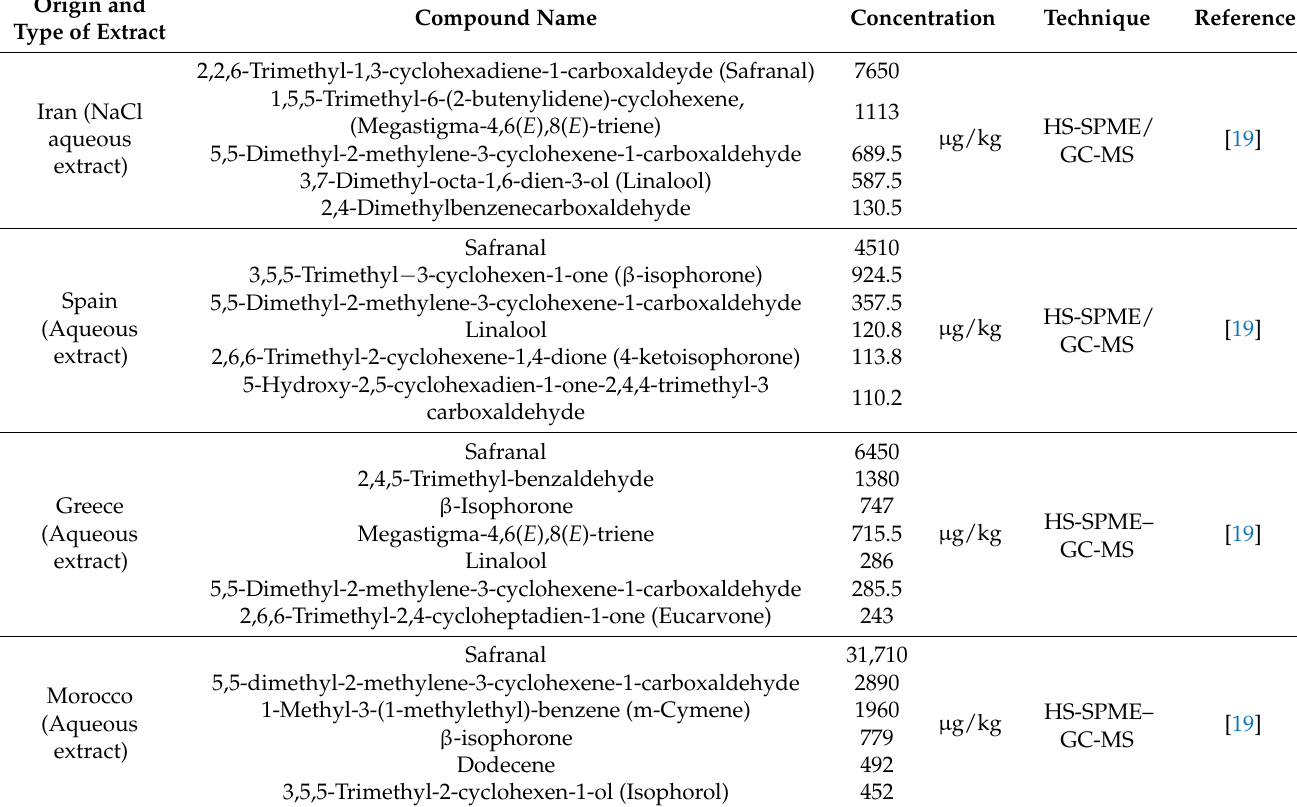
Table 1. Main volatile compounds of saffron quantified by GC obtained from different extracts and geographical origins. Origin and Compound Name Concentration Type of Extract